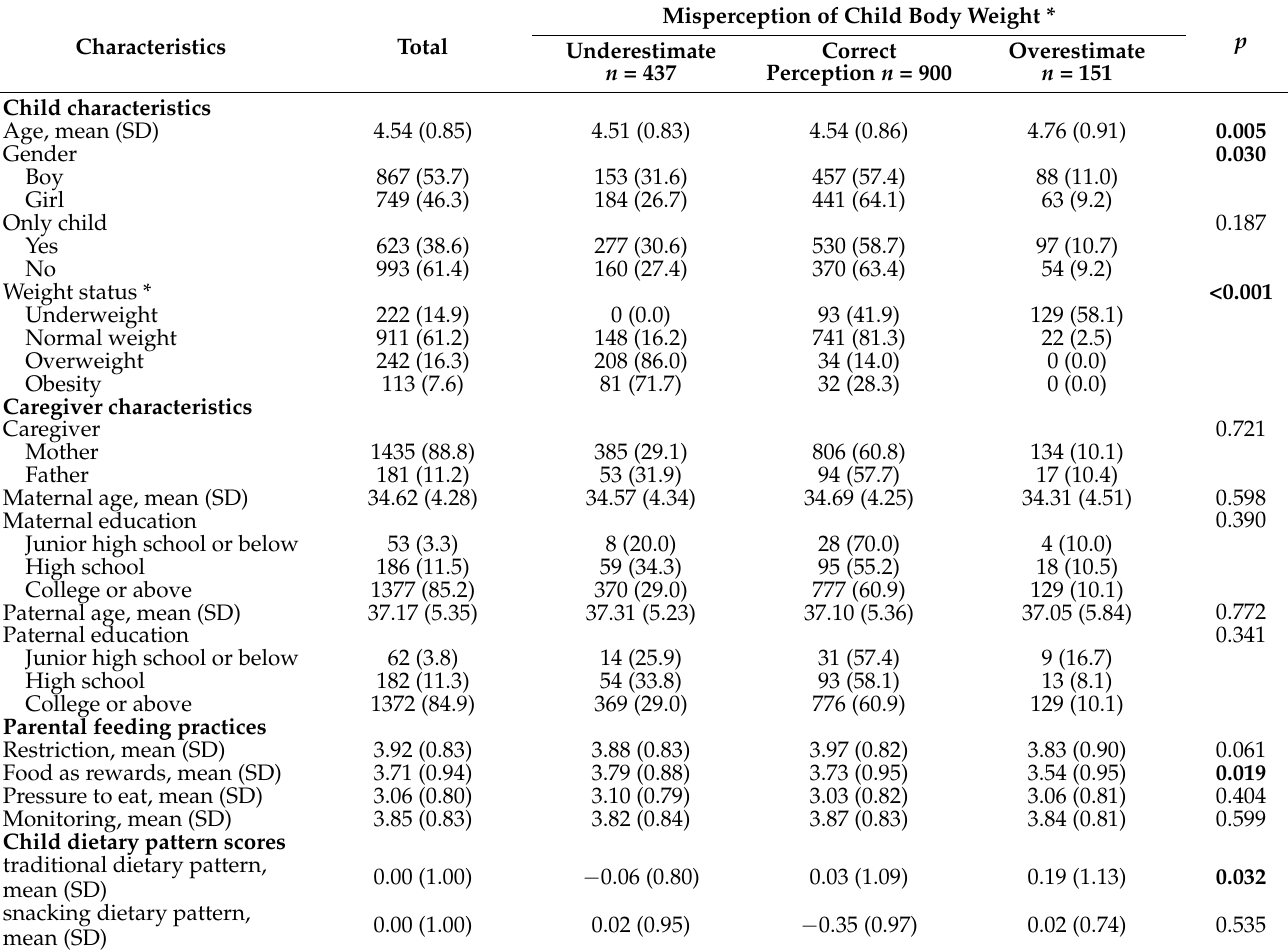
Table 2. Characteristics of children and parents ( n = 1616, n (%) or Mean(SD)). Misperception of Child Body Weight Characteristics Total